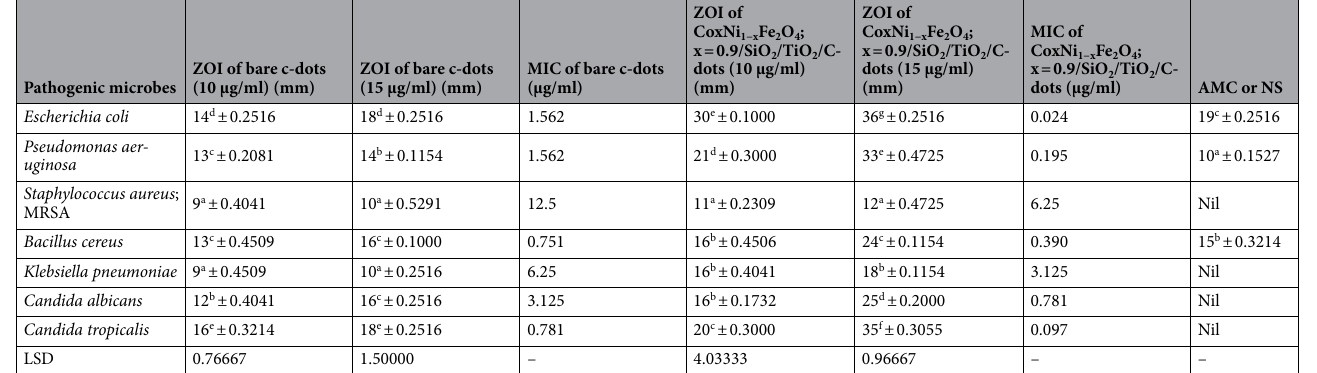
Fig. 16A. Similar results were observed for B. cereus and C. trobicalis biofilm suppression, as shown in Figs. 17b,c respectively. To determine the restraint percentage of bacterial and yeast biofilm, a UV–Vis. spectrophotometer was used (at 570 nm). The optical density (O.D.) was measured after separating the CV-stained bacterial and yeast biofilms through ethanol. Table 2 presents the reduction percentage of the biofilms created by the examined bacteria and yeast strains. The highest suppression percentage was recorded against E. coli (93.92%, Fig. 17a), followed by C. trobicalis (92.35%, Fig. 17c) and C. albicans (66.29%, Table 2) after inoculation with (10 µg/ml) of the prepared nanocomposite. In addition, the newly-synthesized Co x Ni 1−x Fe 2 O 4 ; x = 0.9/SiO 2 /TiO 2 /C-dots nanocomposite was more active against biofilm creation than the previously-synthesized Co x Ni 1−x Fe 2 O 4 ; x = 0.9 /SiO 2 /TiO 2 nanocomposite 47 . It exhibited an inhibition against biofilm-producing E. coli of (93.92%, Table 2), compared with (92.82%) for the Co